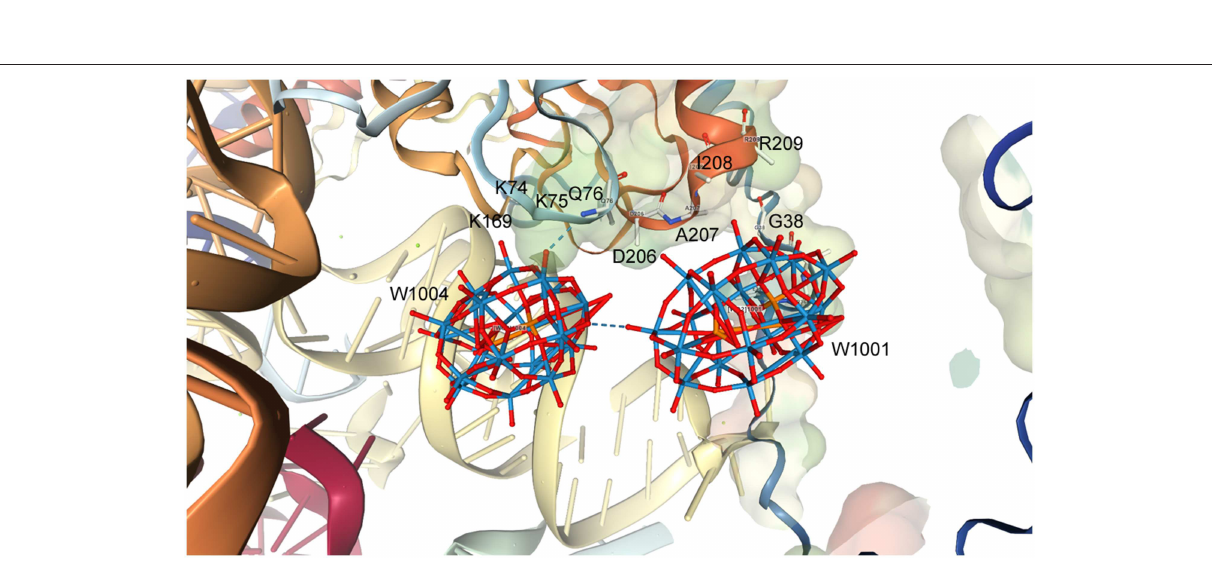
Frontiers in Chemistry | www.frontiersin.org